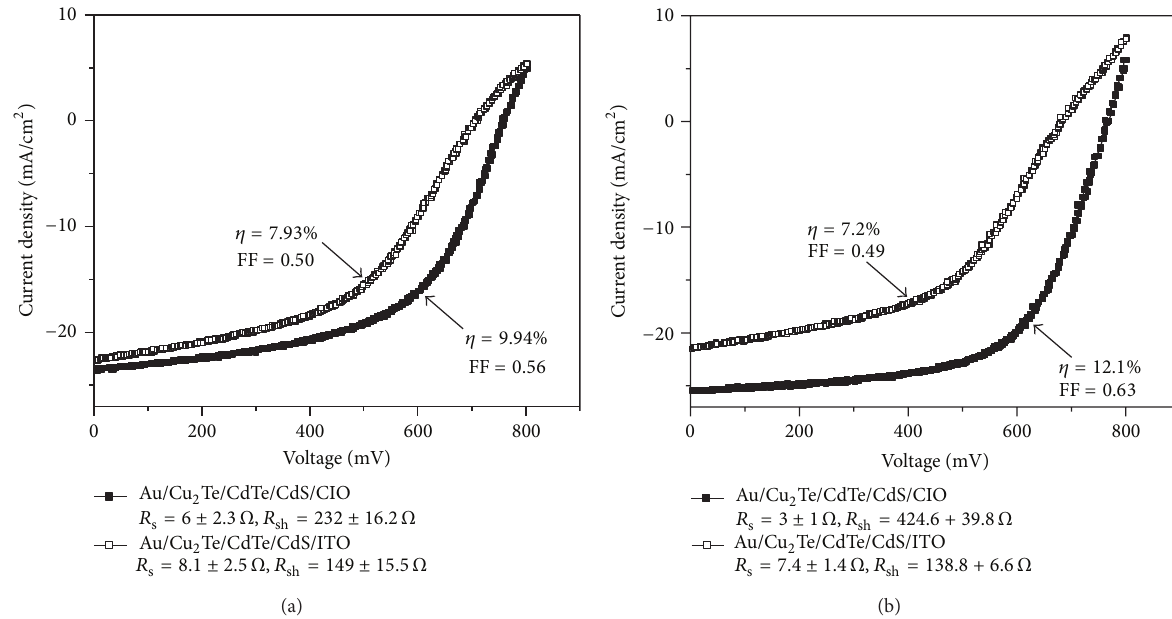
Figure 7: (a) Photovoltaic response of the Cu 2 Te/CdTe/CdS/CIO/glass solar cell and Cu 2 Te/CdTe/CdS/ITO/glass solar cell, with a CdTe layer thickness of 1.8 𝜇 m. (b) Photovoltaic response of the Au/Cu 2 Te/CdTe/CdS/CIO/glass solar cell and Au/Cu 2 Te/CdTe/CdS/ITO/glass solar cell, with a CdTe layer thickness of 3.1 𝜇 m. Both (a) and (b) use the same optimized